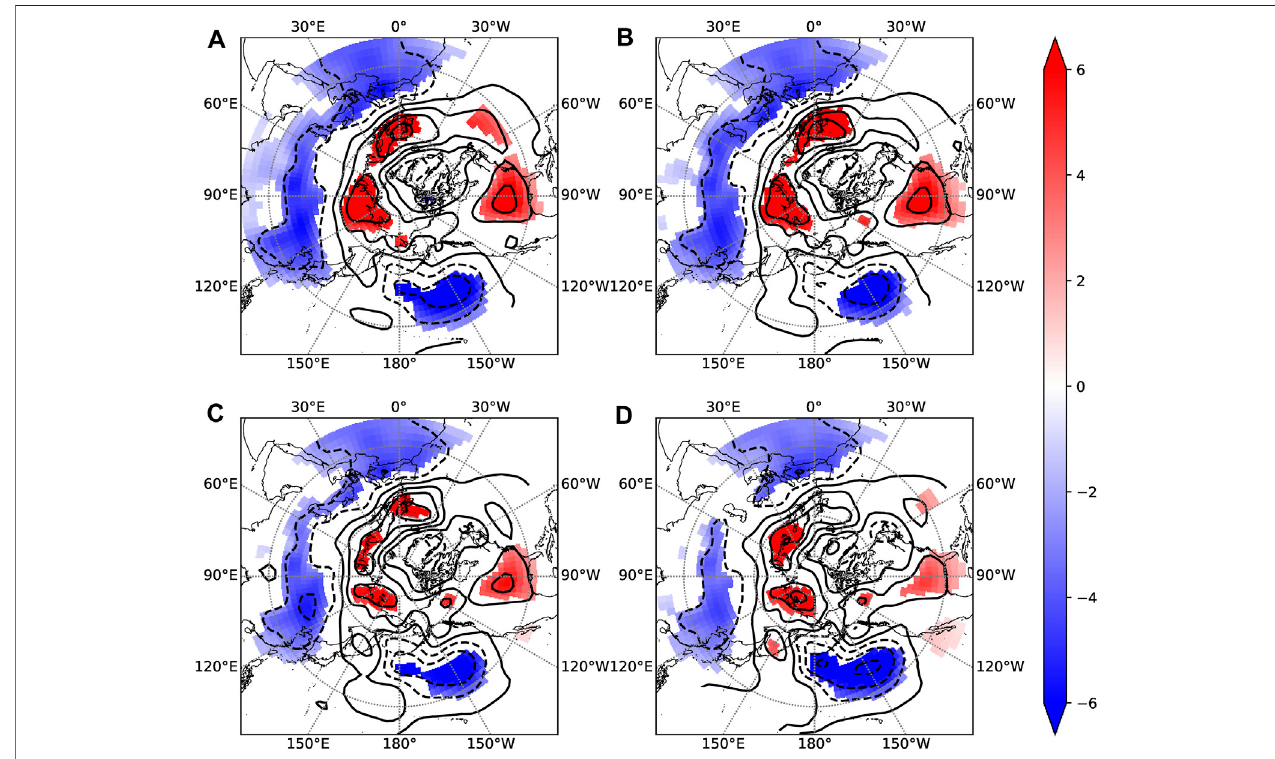
FIGURE 3 | Same as Figure 2 but for the composites of inactive Madden – Julian Oscillation (MJO) events (A < 1). Panels (A – D) present the composites that the MJO leads GH for 0, 5, 10, and 15 days, respectively.